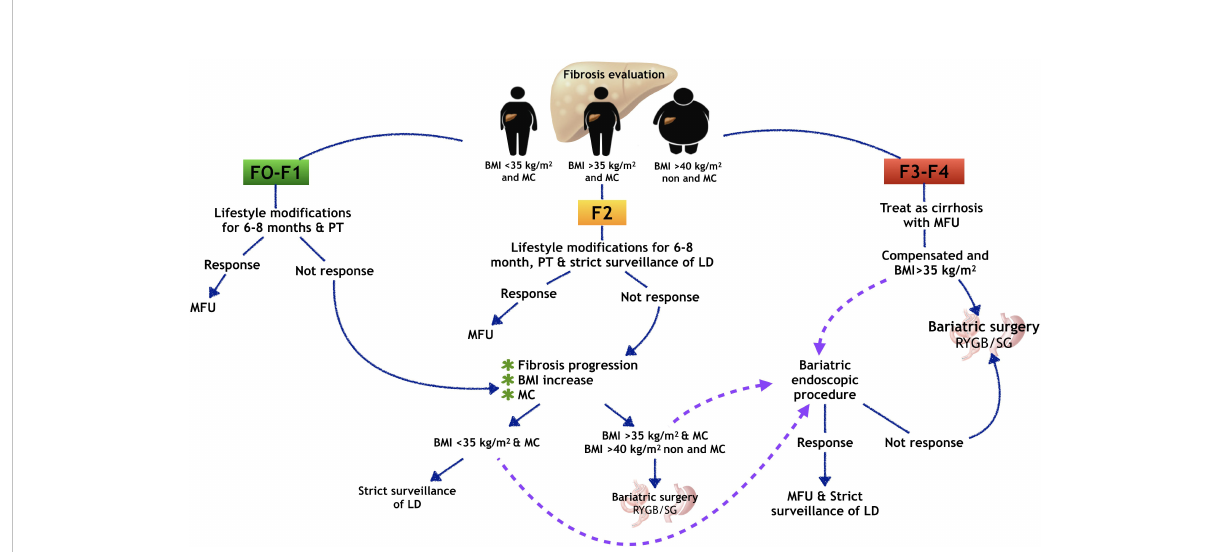
FIGURE 2 Liver fi brosis evaluation and bariatric procedures in patients with NAFLD. MFU, multidisciplinary follow-up; LD, liver disease; BMI, body mass index; MC, metabolic comorbidities; PT, pharmacological therapy; RYGB, Rux-en-Y gastric bypass; SG, sleeve gastrectomy. According to liver fi brosis evaluation in NAFLD patients, in those with F1-F2 lifestyle modi fi cations with optional additional pharmacological therapy are recommended for 6-8 months. Patients with positive response should be continued with medical follow-up. Those patients with non-response and presenting liver fi brosis progression and worsening of BMI and MC could be scheduled to BS. Patients with advanced fi brosis should be treated as cirrhotic; in compensated patients with BMI>35 kg/m2, bariatric surgery could be recommended. The purple dotted lines representing our proposal of evaluating an endoscopic bariatric procedure as bridging therapy before BS, taking to account that more and better evidence are necessary to recommend endoscopic procedures in these